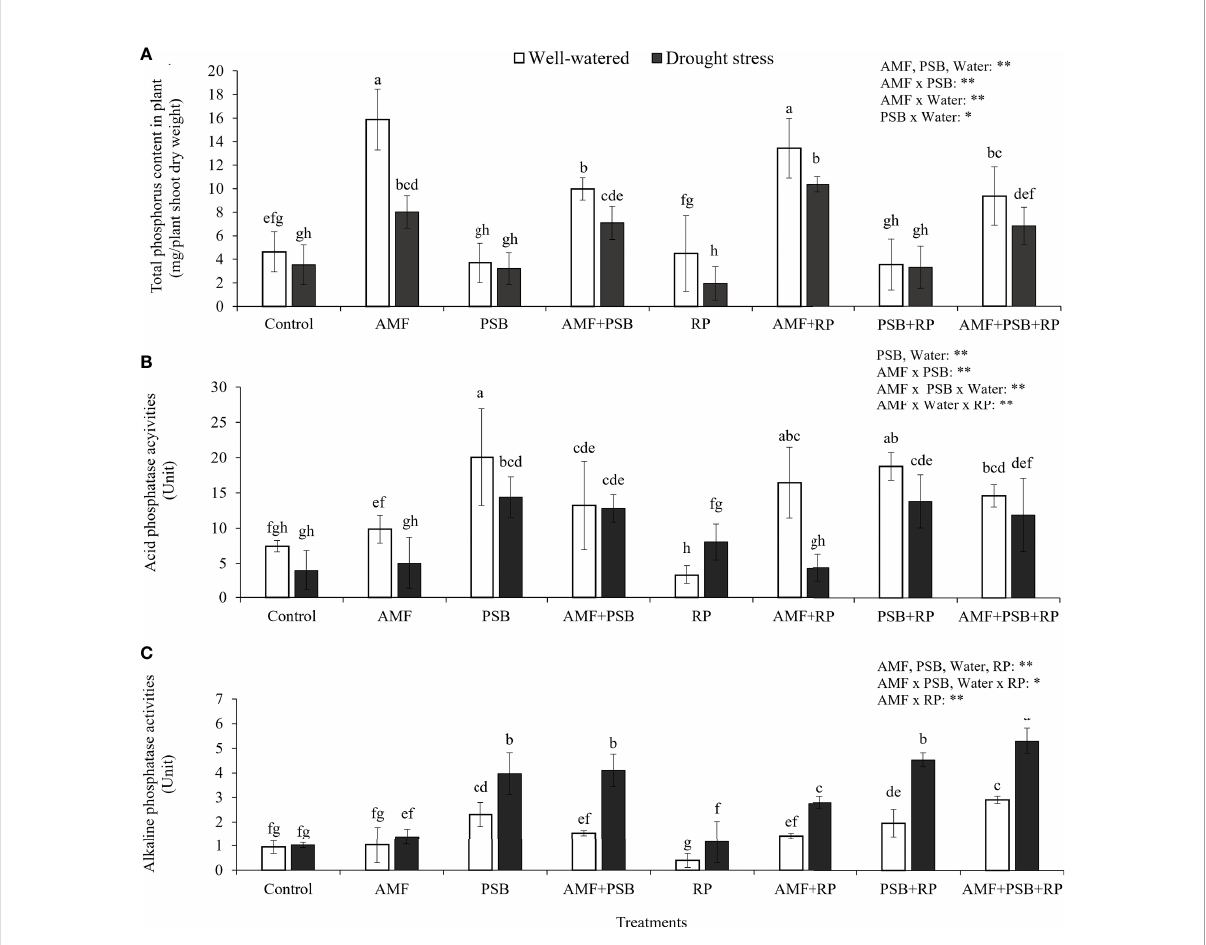
FIGURE 4 Total phosphorus uptake by plants (A) , acid phosphatase (B) and alkaline phosphatase enzyme activities (C) in rhizosphere soil under well- watered and drought conditions evaluated at 60 DAT. Different letters indicate signi fi cant differences at P<0.05 by LSD. Treatment means are the average of four replications. The signi fi cant effects of AMF, water, PSB, RP and their interactions are presented as the F value with test of signi fi cance (*P< 0.05; **P< 0.01) of four-way ANOVA. Non-signi fi cant factors are not